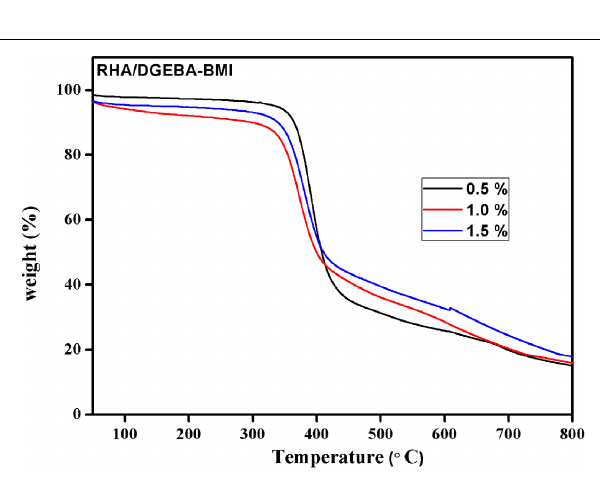
wt. loss of the composites occurred at the temperature of 420.0, 404.2, 424.0, 476.5, and 507.5 ◦ C respectievely. The